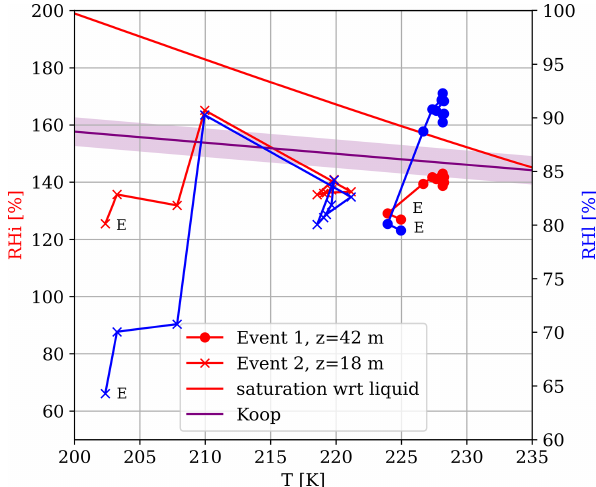
Figure B1. RHi (red curves, left y axis) and RHl (blue curve, right y axis) evolution as a function of temperature at the level of nu- cleation during the initiation phase of the fog. Lines with circles refer to the first event (from 21:00LT on 7 March to 02:00LT on 8 March), while the lines with crosses refer to the second event (from 06:00 to 11:00LT on 25 August). “E” indicates the endpoint. The solid red line shows RHi value at liquid water saturation and the purple line the Koop et al. (2000) homogeneous freezing RHi threshold value.